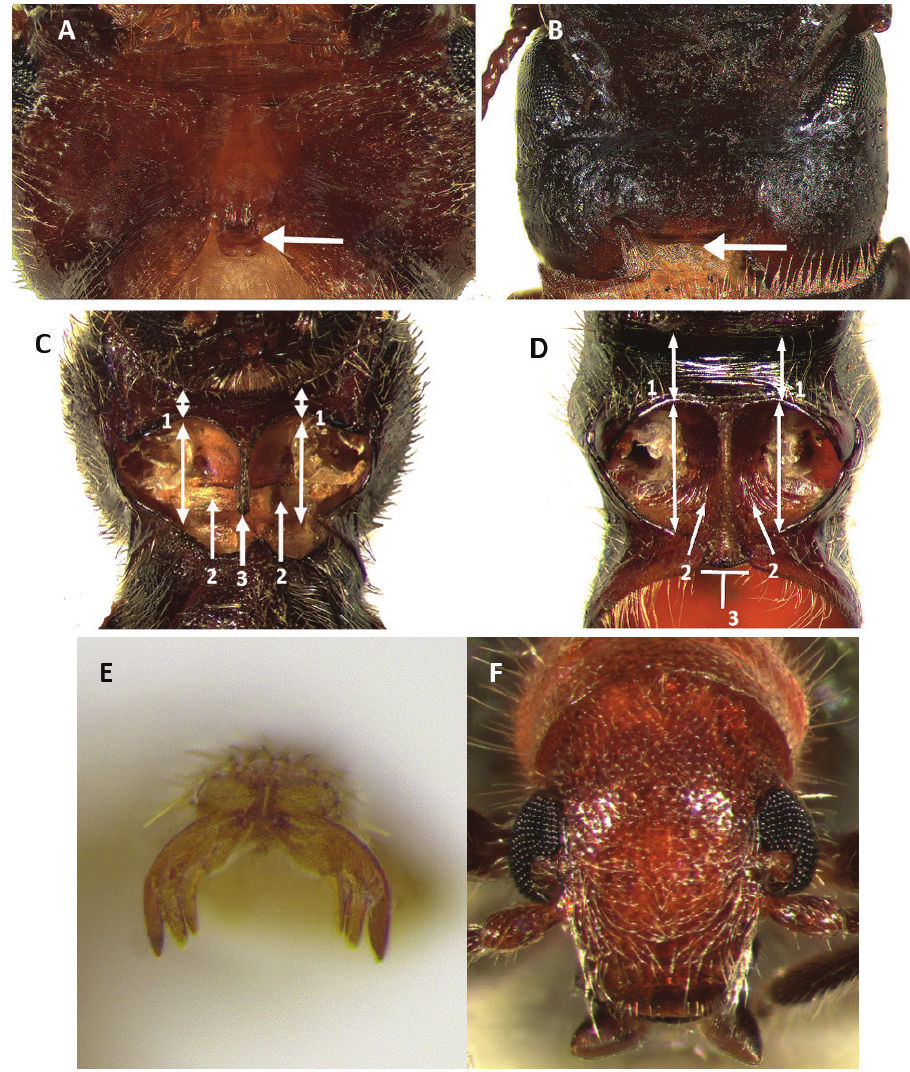
Figure 6. A–B Gular structure of: A Cymatodera californica , arrow indicates post-gular process pre- sent B Temnoscheila virescens (Trogossitidae), arrow indicates post-gular process absent C–D Procoxal cavities of: C Enoclerus zonatus D Cymatodera sallei ; arrows 1 indicate longitudinal length of procoxal cavities in relation to longitudinal length of prosternum; arrows 2 indicate interior portion of procoxal cavities; arrow 3 indicates intercoxal process E Tarsal claw of Araeodontia peninsularis F Eye structure of Cymatoderella collaris .